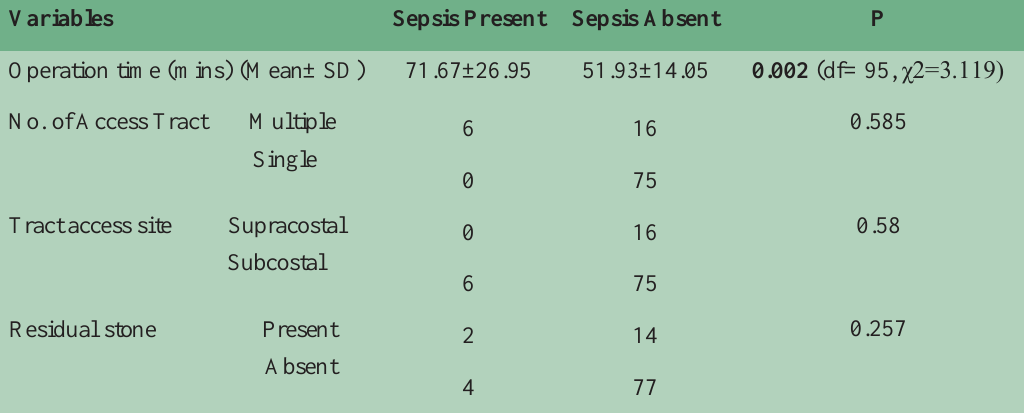
Table 4: Intra-operative parameters in relation to Sepsis (N=97)